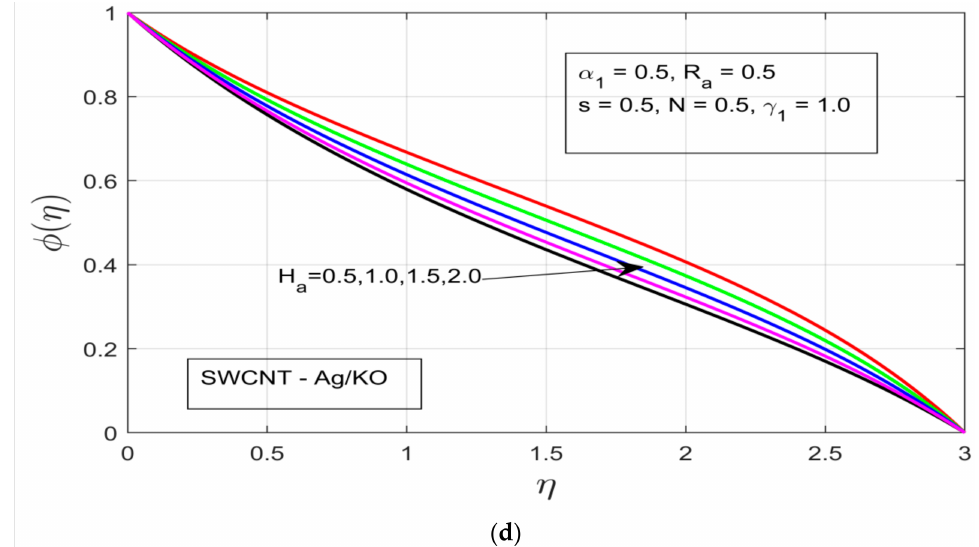
Figure 5. ( a ) Influence of the radiation R a on θ ( η ) . ( b ) Influence of the rotational ratio α 1 on ϕ ( η ) .